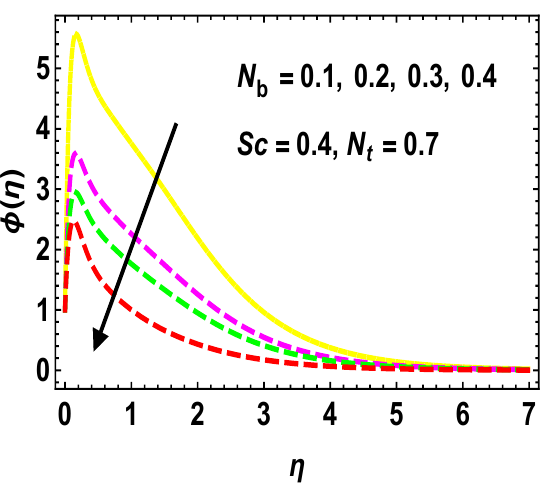
Figure 11. Outcomes of θ ( η ) for N b where yellow, magenta, green, and red lines represent for N b = 0.1, N b = 0.2, N b = 0.3, and N b = 0.4 respectively.